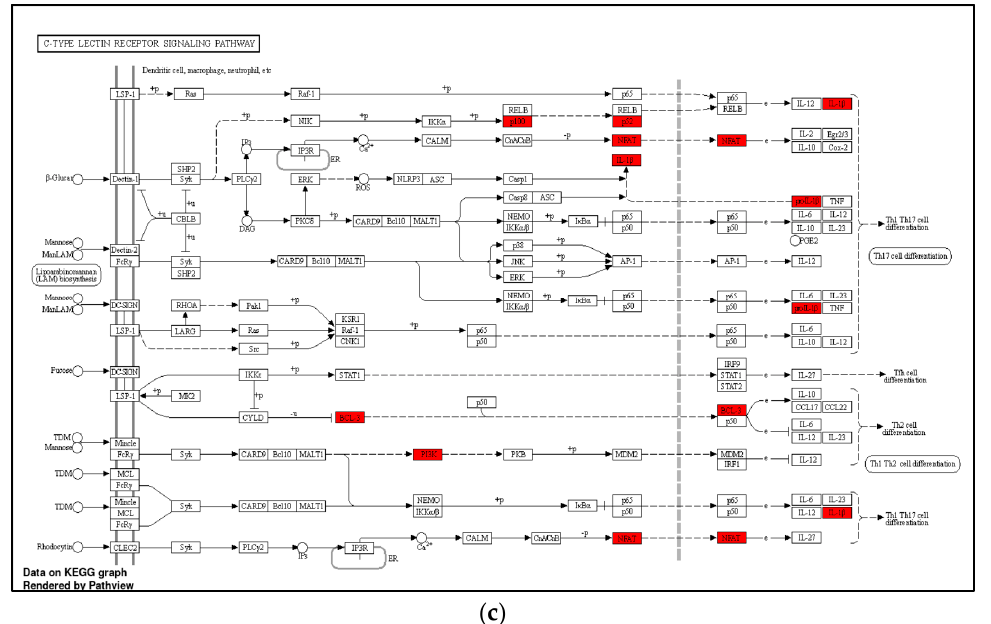
Figure 4. A3 drives signaling pathway-mediated T-cell differentiation status. ( a ) Representative genes regulate the Rap1 signaling pathway confirmed by real-time PCR. The Rap1 pathway is one of the key regulators of T-cell activation [30]. Those genes increased by A3 regulate the Rap1 signaling pathway. ( b ) Representative genes regulate the ( c ) C-type lectin receptor signaling pathway confirmed by real-time PCR. The representative genes regulating activation of the CLR pathway are represented by the red box. Untreated PAMs were used as control. * p < 0.05 compared to PAMs or CD4 group, # p < 0.05 compared to PAMs cocultured CD4 group (without any challenge or treatment), θ p < 0.05 compared to 0.01 MOI, ψ p < 0.05 compared to 0.05 MOI. Data presented as means ± SEM, calculated from 4 pigs.